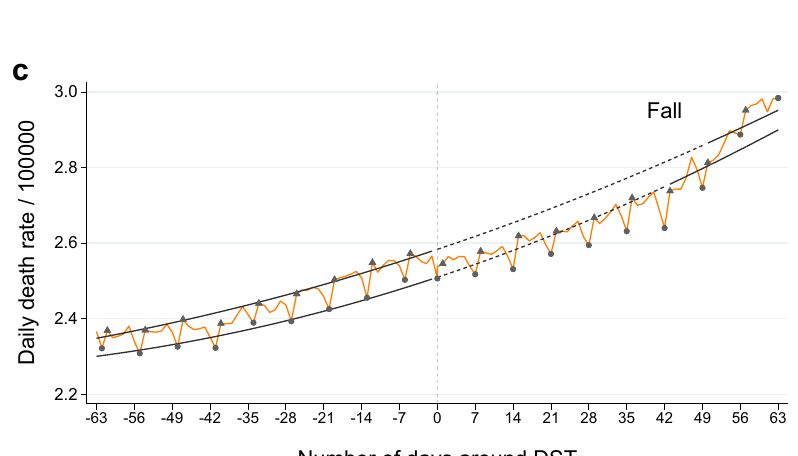
Sundays ( r 2 =0.991) and Monday ( r 2 =0.992), the dotted lines correspond to a 7 weeks interpolation period. c Fall transition with 2nd-degree polynomial regres- sion envelop for Sundays ( r 2 =0.982) and Mondays ( r 2 =0.983), the dotted lines correspond to the interpolation